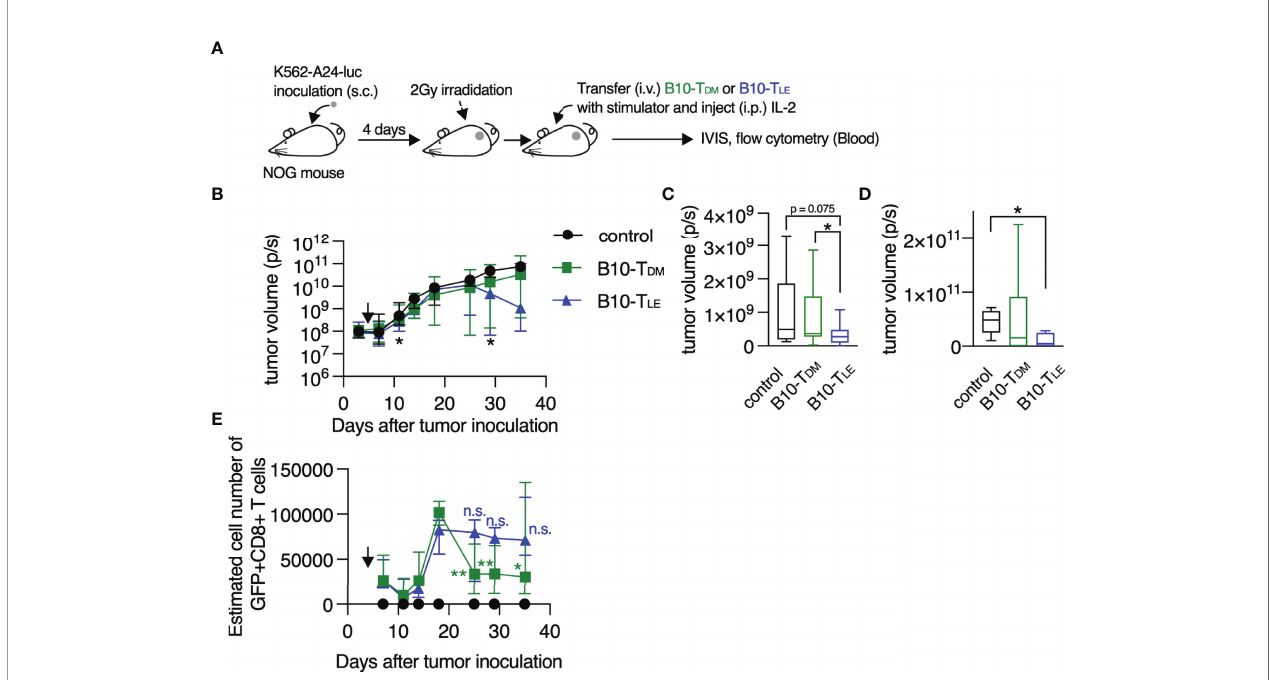
FIGURE 5 | RAR signal blockade confers a strong anti-tumor activity on human T cells. (A) Experimental schematic. B10-T DM or B10-T LE cells were intravenously co-transferred with WT1 peptide-pulsed autologous CD3 + cell-depleted PBMCs into K562-A24-luc tumor-bearing NOG mice. Control mice were treated in the same procedure without T-cell transfer. (B) Kinetics of tumor growth. Signi fi cant differences were observed in the three groups on days 11 and 29 after tumor inoculation, as marked with asterisk (*). Symbols show median with interquartile range. (C) Tumor volume on day 11 after tumor inoculation (control, n = 11; B10-T DM and B10- T LE , n = 17). (D) Tumor volume on day 29 after tumor inoculation (control and B10-T LE , n = 5; B10-T DM , n = 6). (E) Kinetics of persistence of GFP + CD8 + T cells. GFP + CD8 + T cells in B10-T DM signi fi cantly decreased from a peak (day 18), whereas those in B10-T LE persisted. Symbols show median (with interquartile range) of estimated number of cells (each group, n = 6). The estimated number of cells were calculated from frequencies of GFP + CD8 + cells in blood. Data from six (B, C) or two (D, E) independent experiments were analyzed by Mann-Whitney test (C, D) or paired t-test ( E ; day 18 vs. day 25, 29, and 35). *p < 0.05; **p < 0.01. n.s., not signi fi